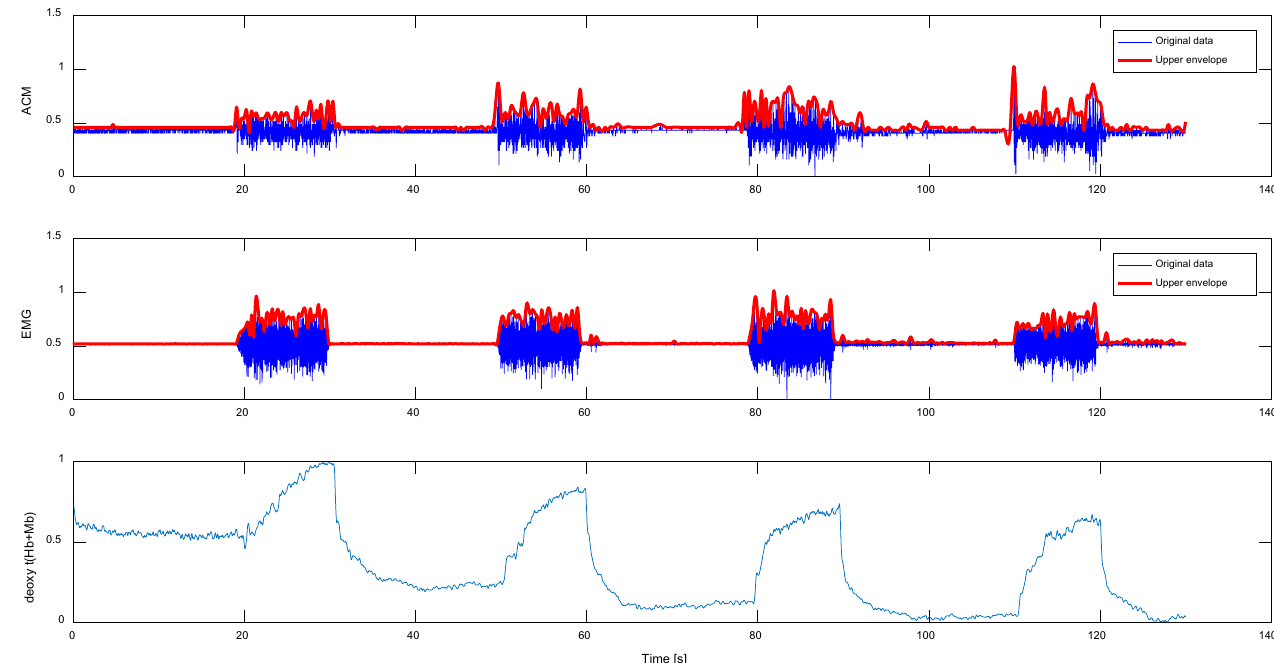
Fig. 3. Signal responses from ACM, deoxy (Hb þ Mb) and sEMG during a static exercise. There is a strong °uctuation in all the three signals caused by the four static